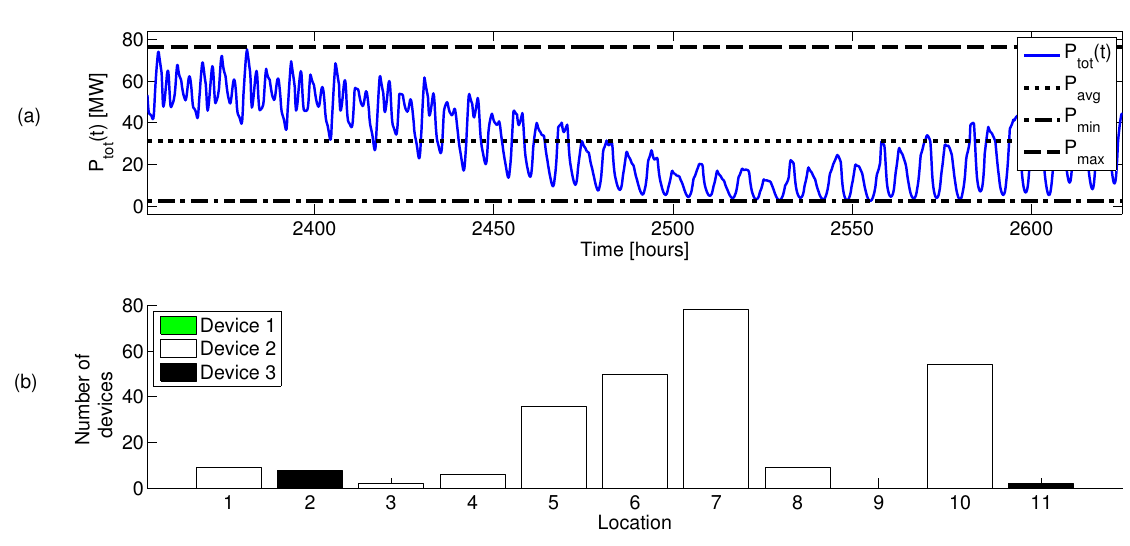
Figure 8. Simulation results for Solution 10 (solution with the lowest power variance). ( a ) Zoom of the total power P tot ( t ) ; ( b ) Number of installed devices at each location.